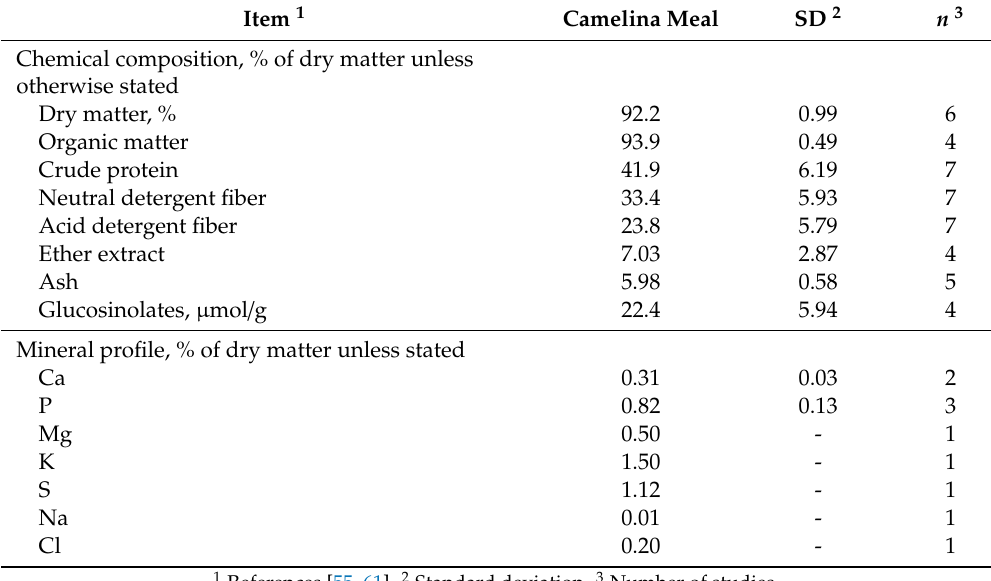
Table 3. Chemical composition (% of DM, unless otherwise stated) of camelina meal (CMM)